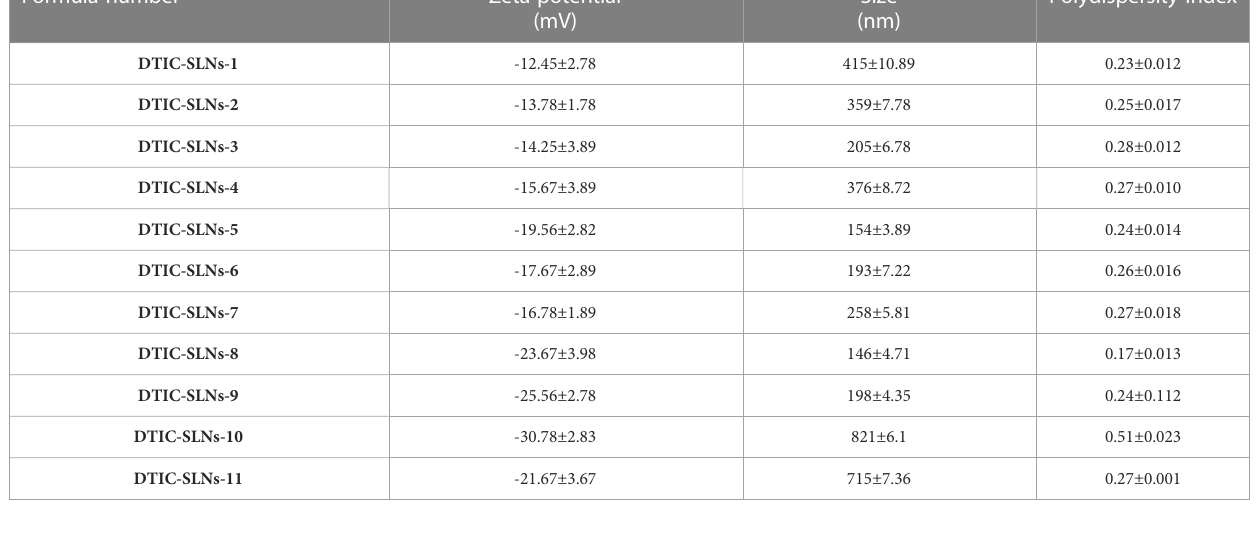
TABLE 2 Zeta potential, Size and polydispersity index values of different SLN formulas (mean ± SD, n=3). Formula